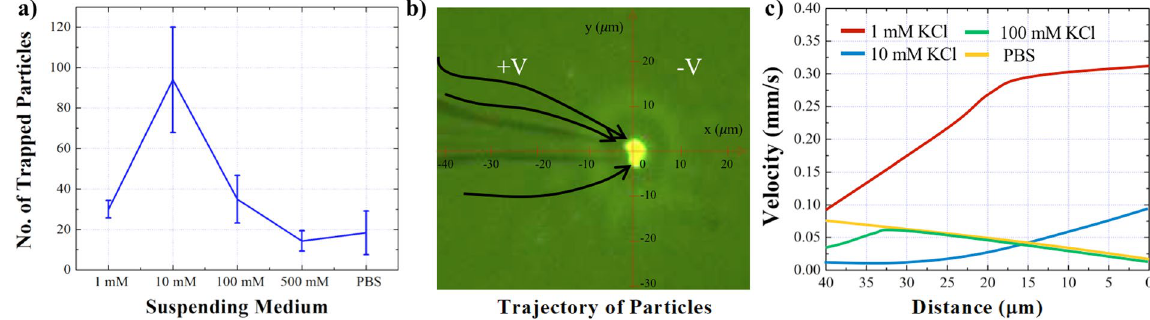
Figure 4. ( a ) The correlation between the estimated number of trapped particles and the ionic strength of the solution at pH 7.0. Each experiment was conducted using a 1 μ m pipette under 10 V/cm and the data was collected at 100 seconds after the positive voltage was applied at the base of the pipette. ( b ) The trajectory (black arrows) of the beads motion before getting trapped at the tip, (0, 0) point. ( c ) The velocity of the COOH-PS beads suspended in solutions with different salt concentrations with respect to their distance from the tip, point (0, 0). The distance was obtained from the particles’ coordinate with respect to the pipette’s tip as shown in figure b).